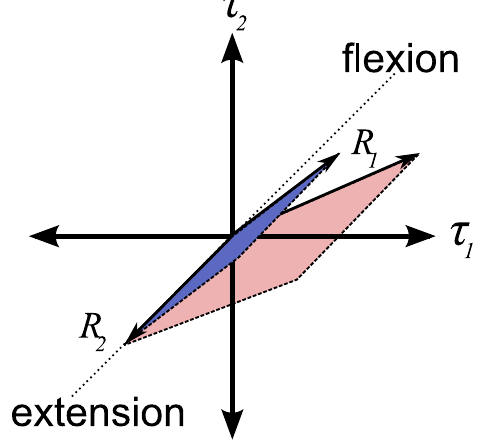
Figure 7. For limited tendon tensions, the torque space is defined by the above parallelogram. The ratio of r 1 conditioning of the possible